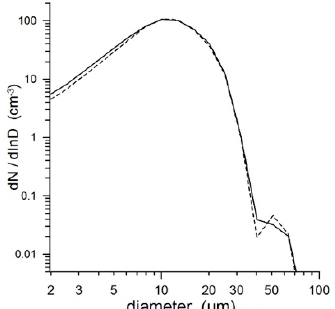
Figure 7. Drop size number density distribution function in cm − 3 at 1370 m altitude, averaged over all cloudy grid points (LWC > 0.03 g m − 3 ) of the domain at 200 min (dashed curve) and at 240 min (solid curve).